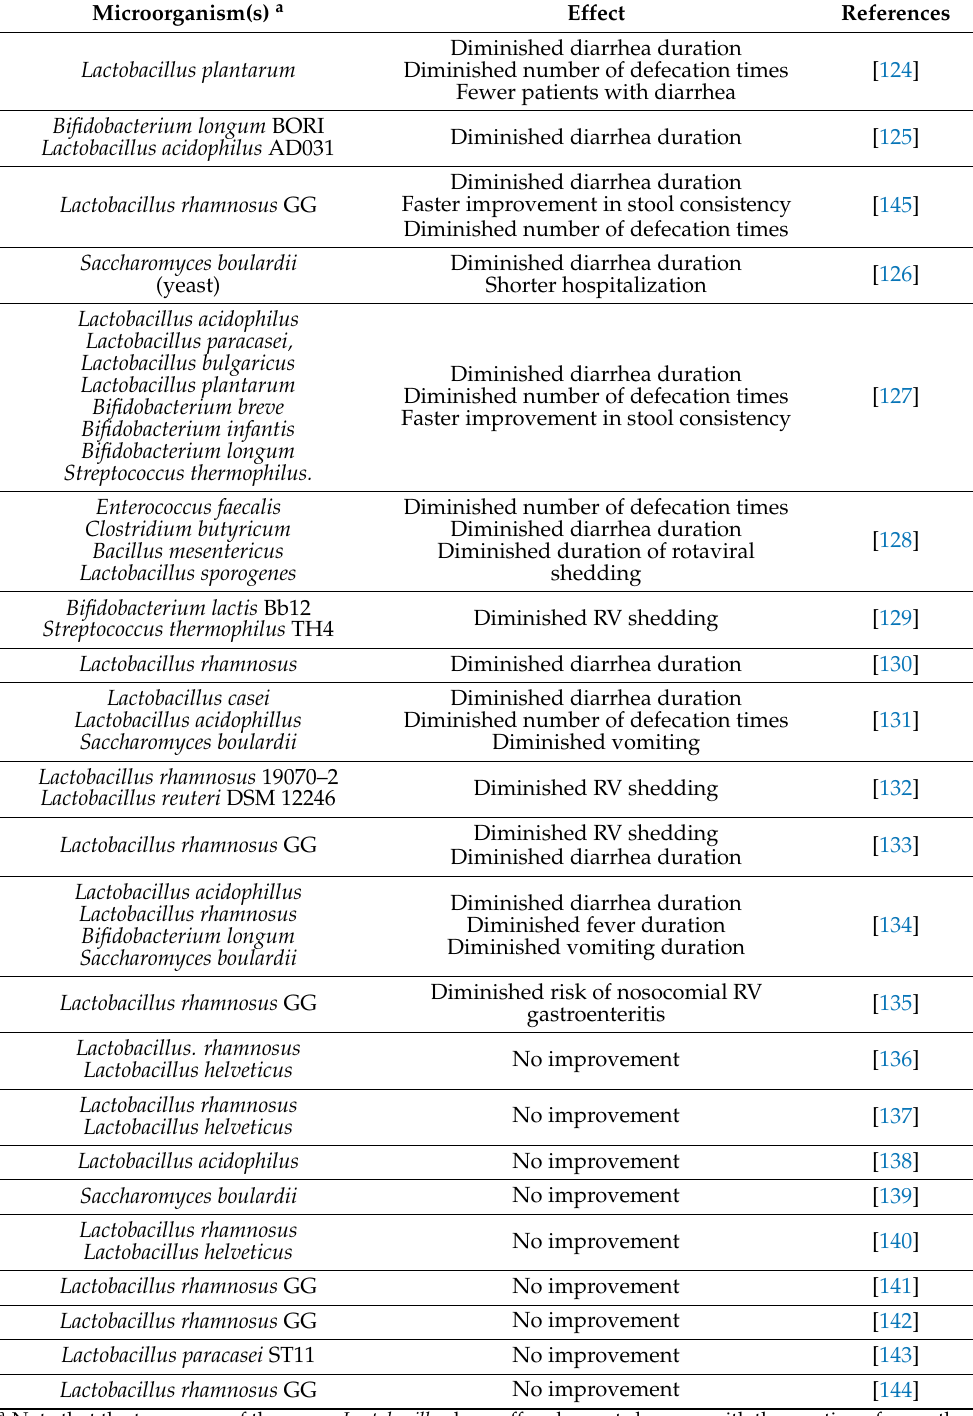
Table 1. Effect of probiotics in the treatment of RV in clinical